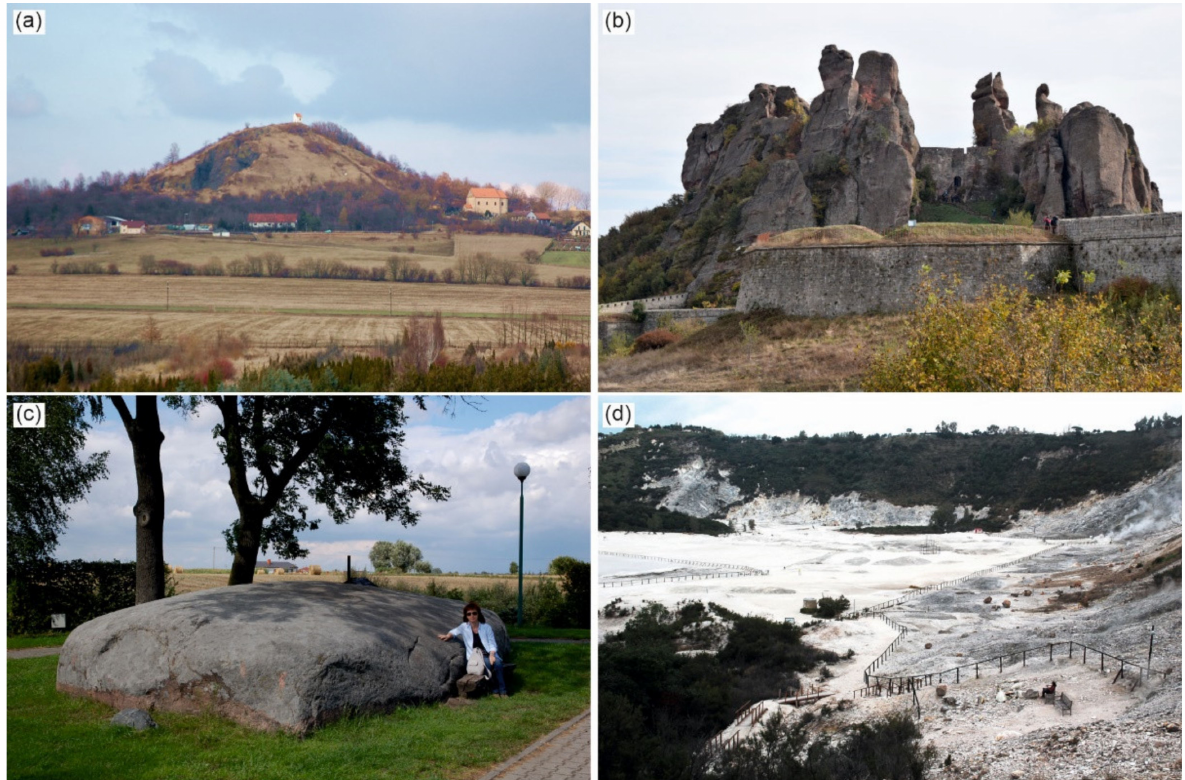
Figure 1. Geomorphosites with additional cultural values. ( a ) cinder cone of Zeb í n in the Bohemian Paradise UNESCO Global Geopark is an important geosite, with the medieval church at the foot (right) and a baroque chapel on the top, ( b ) conglomerate rock city of Belogradchik, Bulgaria, with remnants of the Kaleto fortress incorporated into it, ( c ) a large erratic boulder in central Poland (Budziejewko village), associated with various local legends, ( d ) Solfatara in Pozzuoli, Italy, is a world-renowned volcanic geosite, visited and used for therapeutic reasons since antiquity (all photographs by the